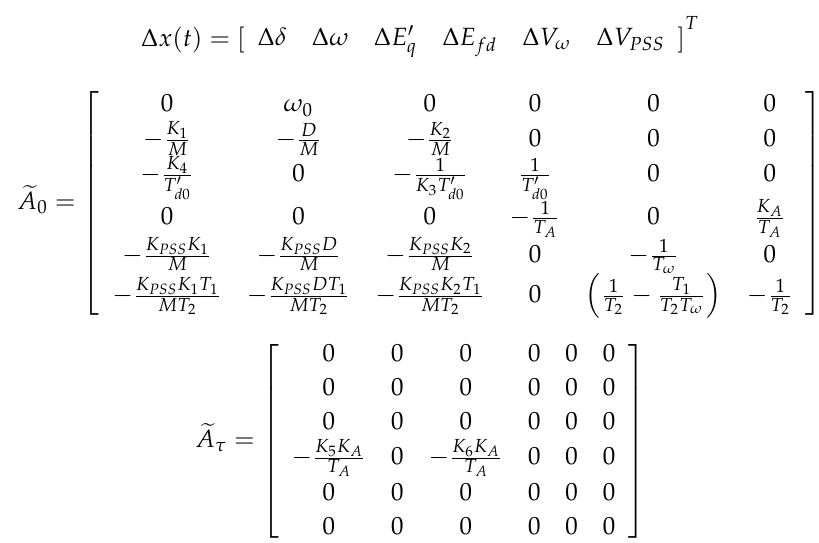
Figure 5. The block diagram of the power system stabilizer.